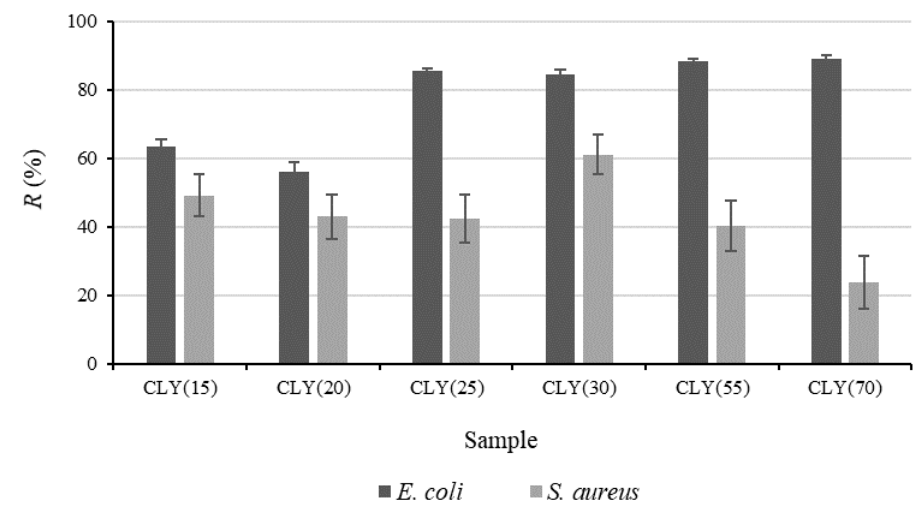
Figure 2. Reduction, R , of Escherichia coli and Staphylococcus aureus versus the mass fraction of CLY fibers, w CLY , in the fiber blend samples CLY(15) to CLY(70). The K sample was used as a reference.